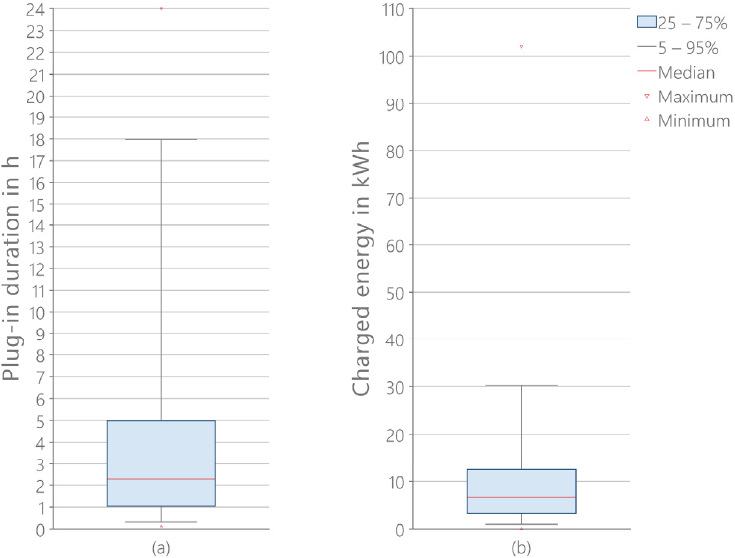
Figure 2. Statistical evaluation of processed data on plug-in duration ( a ) and charged energy ( b ).